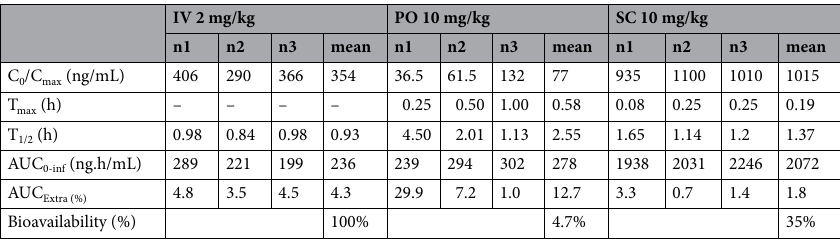
Table 2. Pharmacokinetic properties of BW following different route of administration: per os (PO), intravenous (IV) or subcutaneous